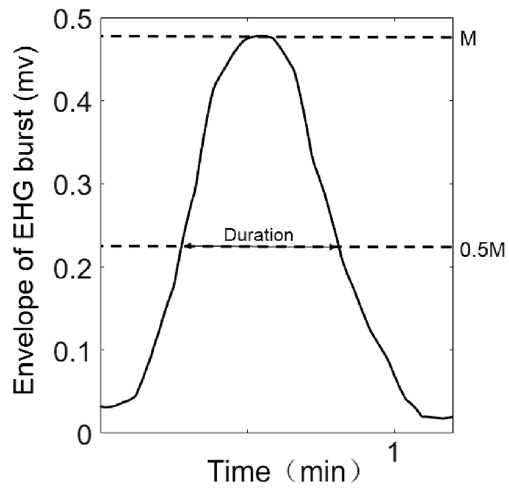
Figure 7. The definition of UC